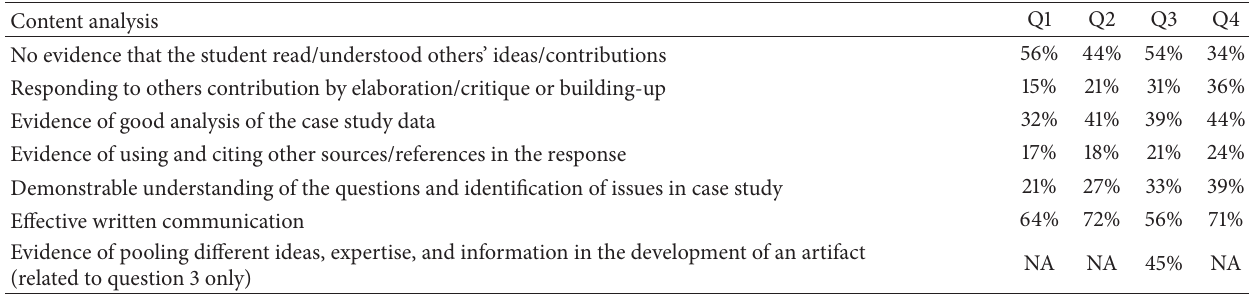
Table 4: Summary of analysis.